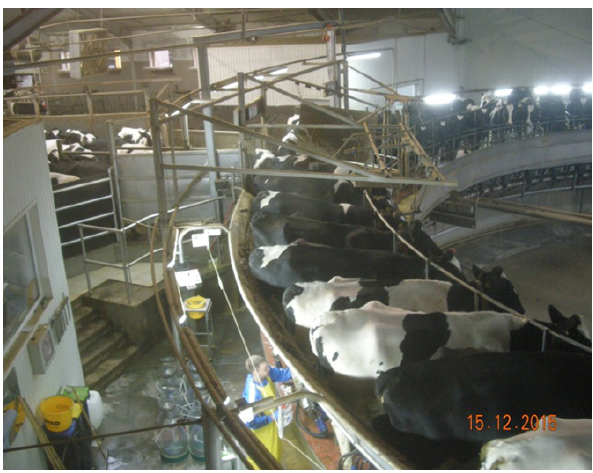
Figure 5. A 60-point carousel milking parlour. Table 1. Milk yields of primiparous cows in the course of